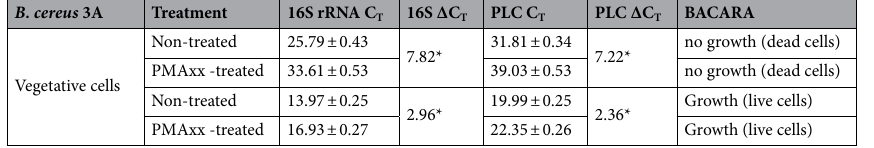
Table 4. Detection of viable cells of B. cereus 3A in in artificially contaminated liquid-type samples using singleplex PMAxx -qPCR and BACARA plates. *indicates a statistically significant difference ( P < 0.0001), Δ C T indicates the differences between PMAxx -treated and non-treated C T values. N = 3